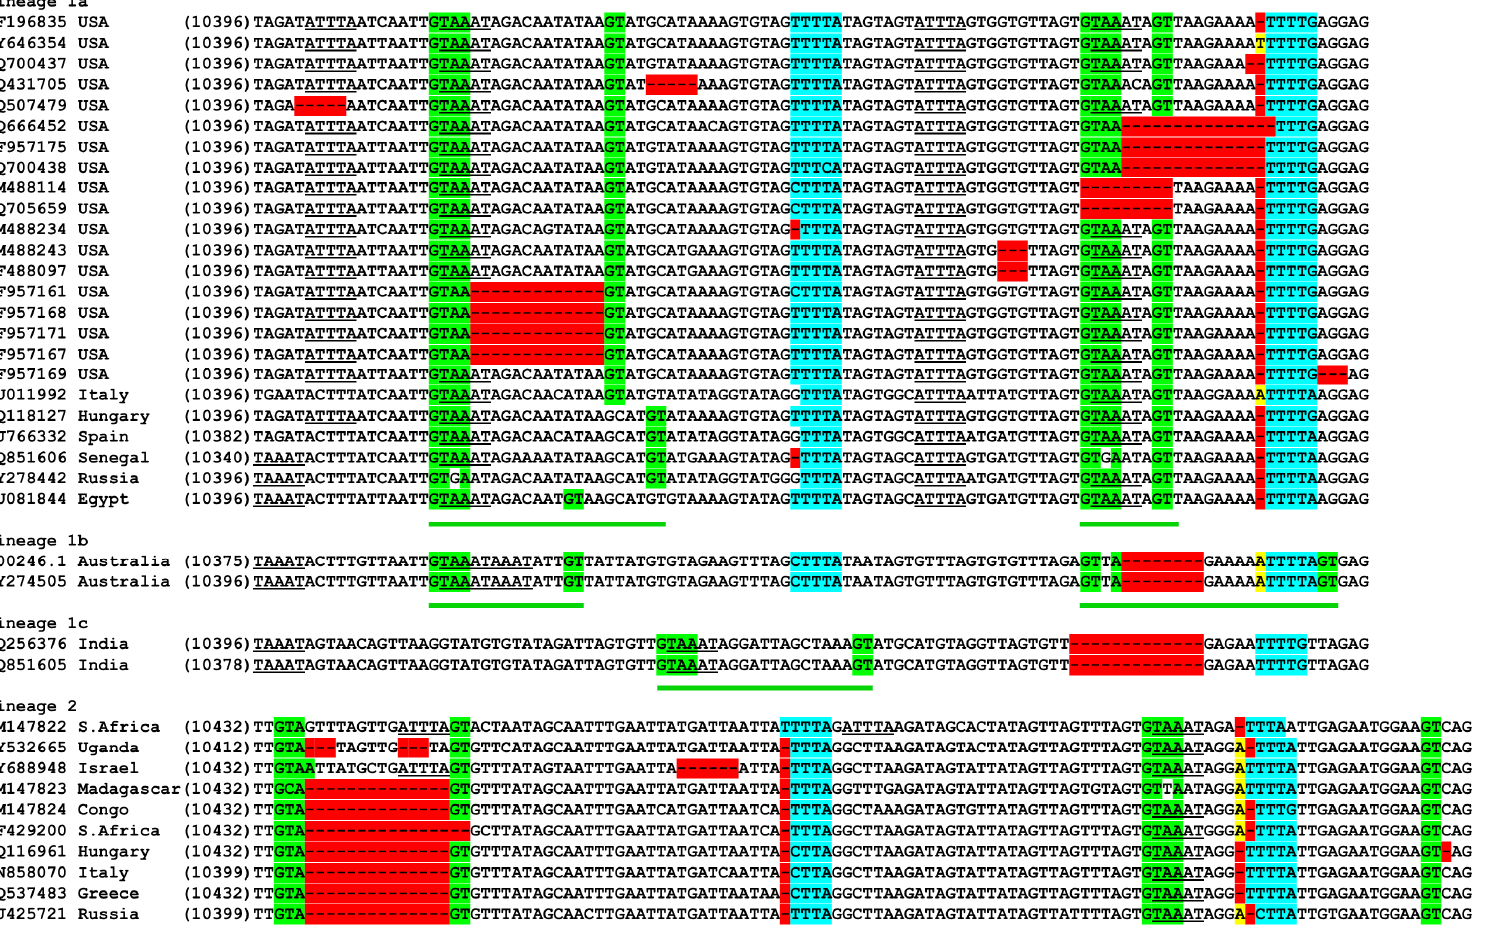
Figure 3. Partial nucleotide alignment of the 3 ′ UTR of two major lineages of WNV isolated from the U.S. and other countries. GTAAATA(N) GT repeats underlined by green lines. GTAAGT and YYYTR (Y = C/T; R = A/G) indel motifs are highlighted in 0-29 green and blue colors respectively. Deletions are shown in red and insertions in yellow. AREs (ATTTA and TAAAT) are underlined. Isolates JF957161–JF957171 contained the ID- Δ 13